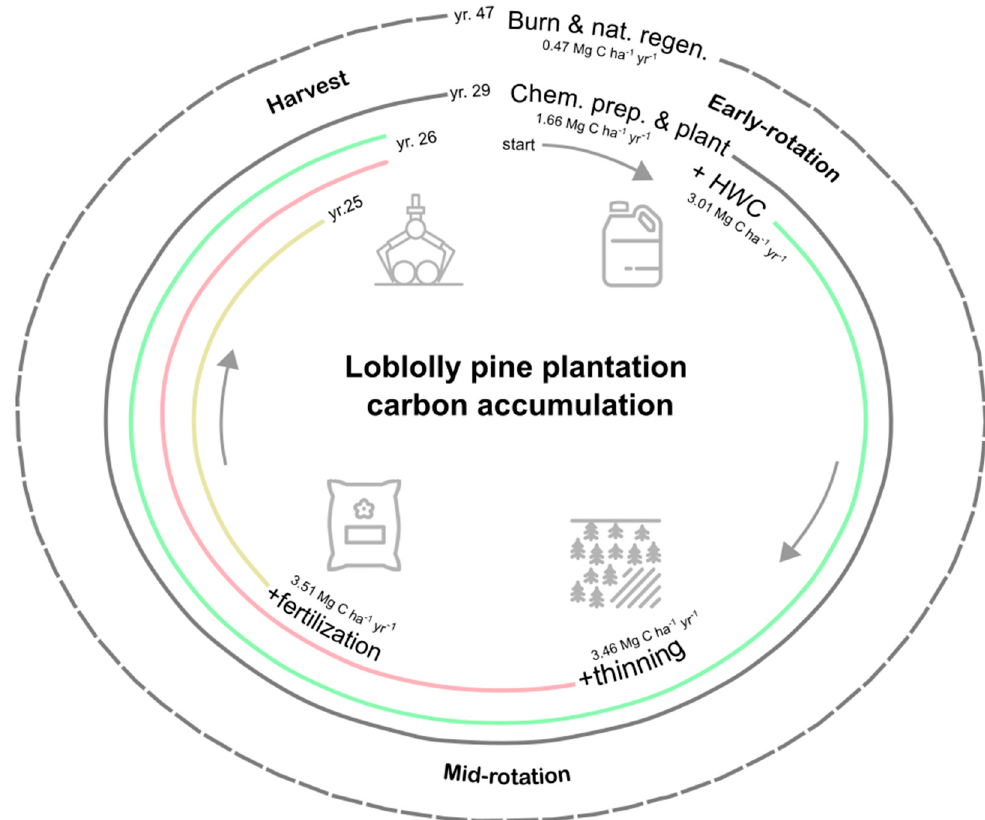
Figure 1. Loblolly pine plantation aboveground carbon accumulation rates with common operational silviculture, i.e., chemical prep and plant = chem. prep. and plant only; fertilization = chem. prep. and plant + herbaceous weed control (HWC) + thinning + fertilization. Number by treatment = average yield till harvest. Dashed circle = baseline. Arc terminus = rotation age. Data from Oneil [56], where harvest was determined at 6% return-on-investment, and the data represent Southern averages, not an existent stand.